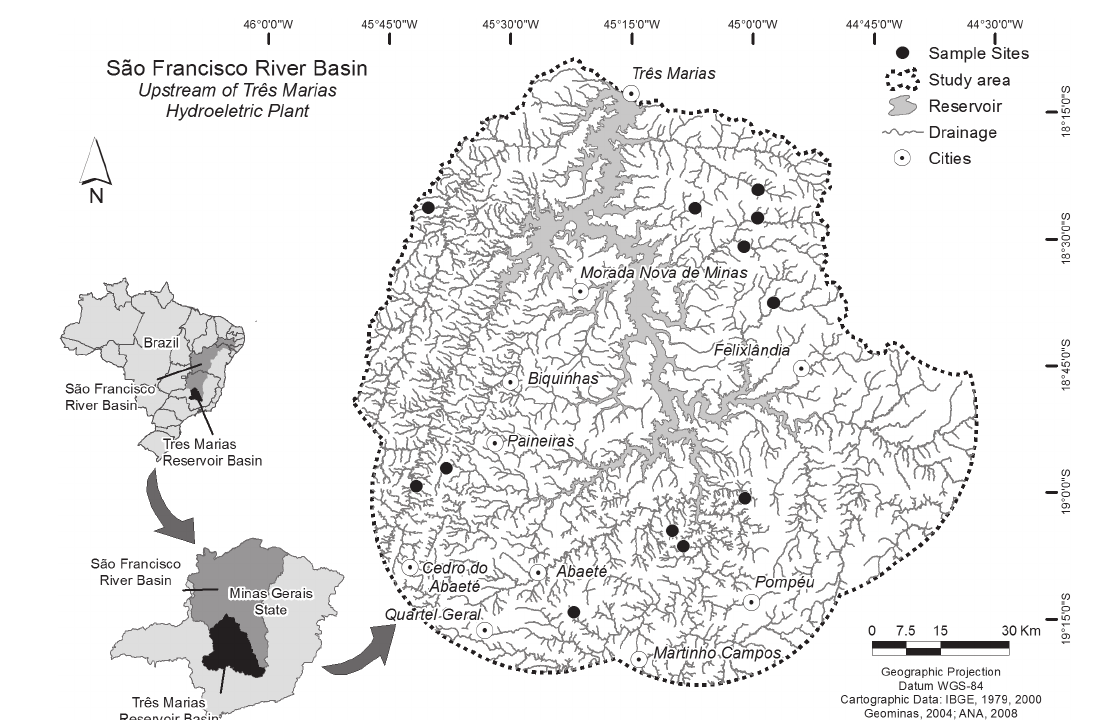
Figure 1. UHE Três Marias area consisting of 12 streams that were 1 st , 2 nd , and 3 rd order tributaries of this